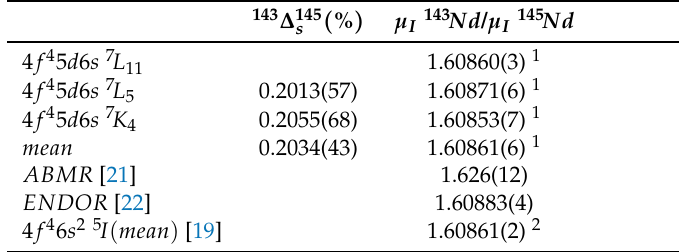
Table 2. Hyperfine anomaly (hfa) and magnetic dipole moment ratios in